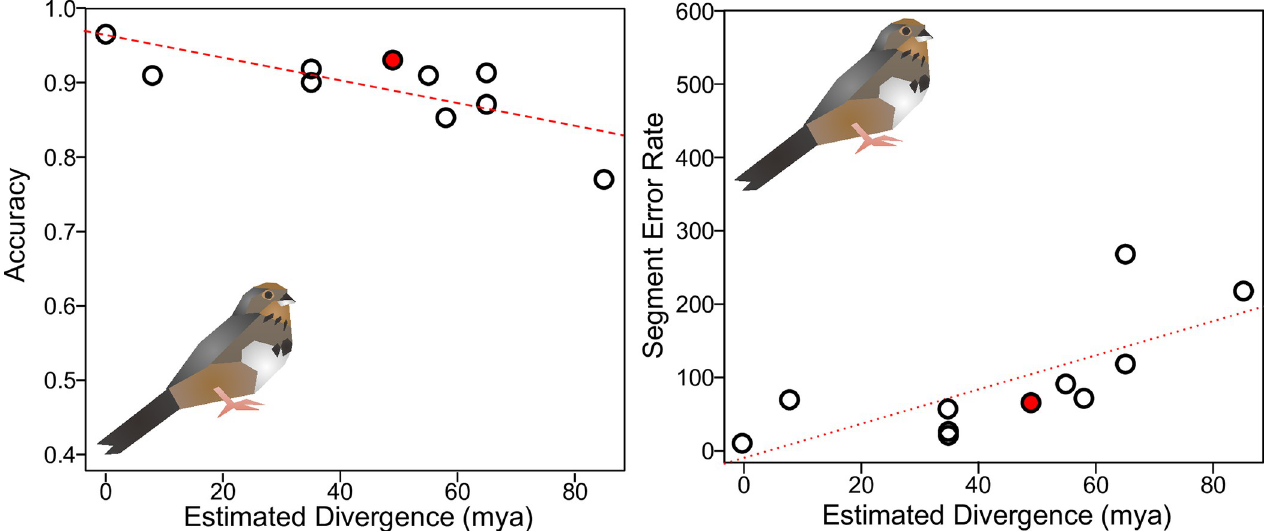
Fig 6. Model performance on Melozone fusca drops with estimated divergence, but also shows recovery when trained on multiple species. X-axis gives the estimated divergence time. Y-axis gives the accuracy (left) or segment error rate (right). Hollow black points show single-species models. Filled red points show multiple-species models. Red line shows the overall line of best fit. Solid line shows a significant relationship, while dotted line is not significant (see S8 Table in S1